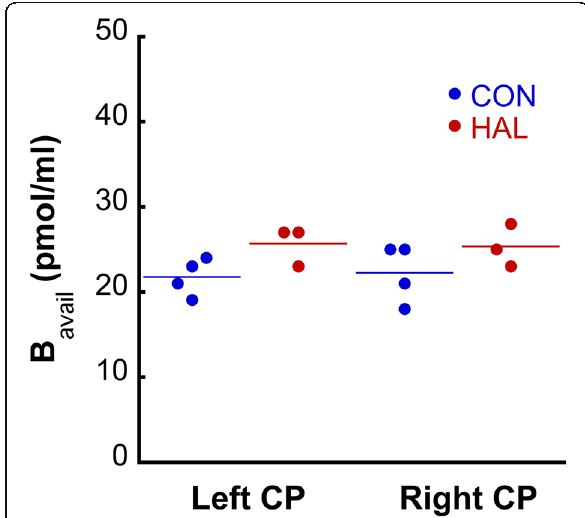
Fig. 8 Result of the preliminary study of the effect of a chronic haloperidol treatment on the B avail values in the rat left and right